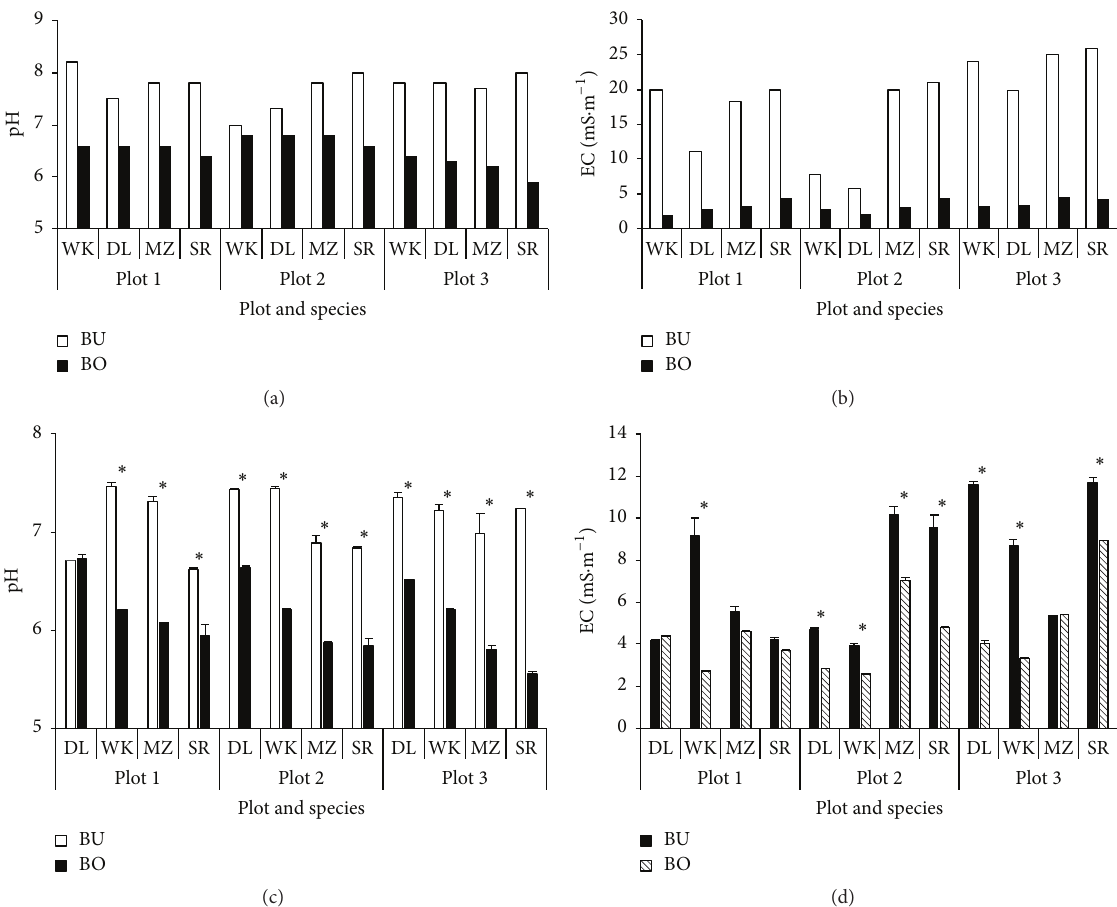
Figure 1: Changes in soil pH (a) and soil electric conductivity (EC, (b)) at the harvest on November 7, 2012, and soil pH (c) and soil EC (d) on November 16, 2013. For plots 1–3, animals were mainly buried in plot 3, sanitizing and slaughtering materials were mainly buried in plot 1, and both of animals and materials were buried in plot 2. Abbreviations of species are as follows: napiergrass cv. Wruk wona (WK), and dwarf variety of late-heading type (DL), maize (cv. Ohka, MZ), and sorghum (cv. Sanjaku sorgo, SR). ∗ shows the difference between BU and BO areas at 5%